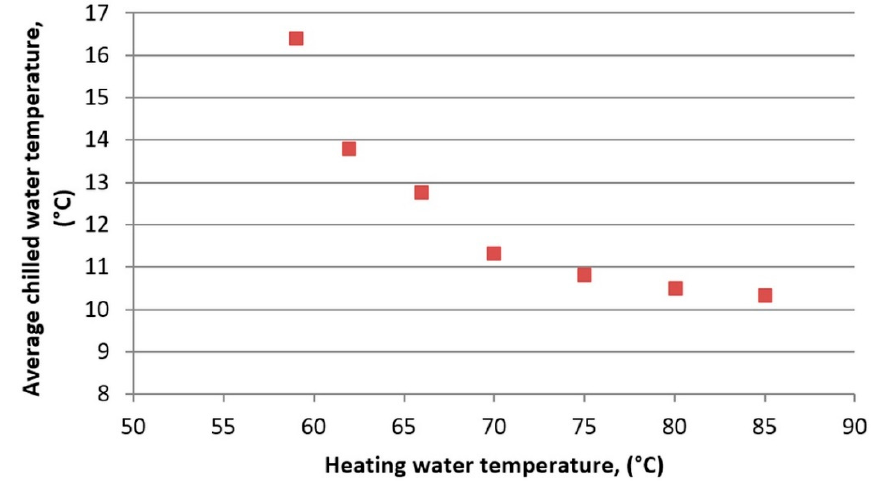
Figure 5. The influence of the heating water temperature on the average chilled water temperature.